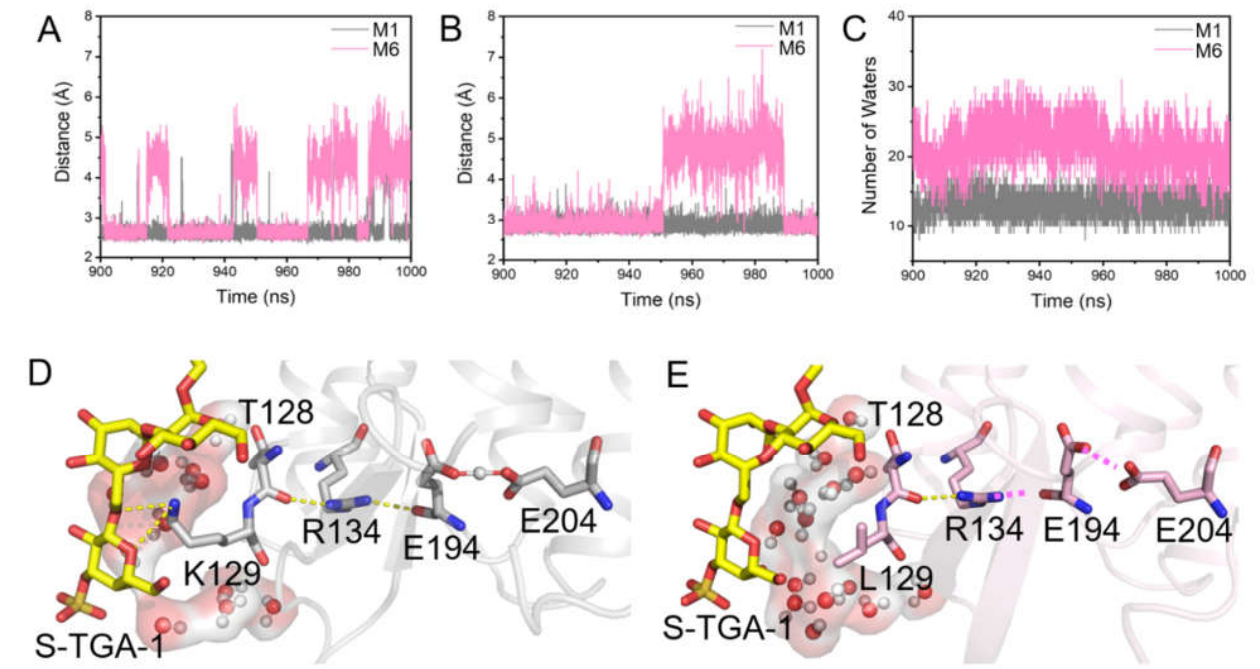
Figure 8. Dynamic conformational changes of the key residues on the extracellular side of bR induced by the K129L mutation. ( A , B ) The evolution of the distance between the key residues from the last 100 ns simulations of M1 (grey line) and M6 (pink line): ( A ) E194-E204; ( B ) R134-E194; ( C ) time series of the number of water molecules around K/L129 and T128 in the last 100 ns simulations of M1 (grey line) and M6 (pink line). This behavior could be reproduced in the second time-repeat simulation (Figure S11 and Table S5); ( D , E ) schematic diagrams of the H-bond network connecting K129 and the proton release complex (PRC) in M1 ( D ) and M6 (E) . The grey cartoon and sticks were used for M1, pink cartoon and sticks were used for M6, yellow sticks represent S-TGA-1, red spheres, and the transparent surface indicates the water chains around K129 and T128, respectively. The pink dotted lines show unstable H-bond interactions.